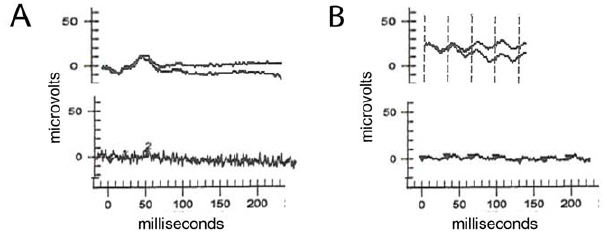
Figure 4. Electroretinogram responses from patient IV-4 with photopic single flash and 30 Hz flicker response stimuli. Both panels show responses at younger age 38 years on top and at 55 years on bottom. The single flash cone responses at age 38 was reduced approximately 80% from normal and was no longer detectable 17 years later (Panel A). The cone flicker response was similarly reduced at age 38 and further diminished by age 55 (Panel B).